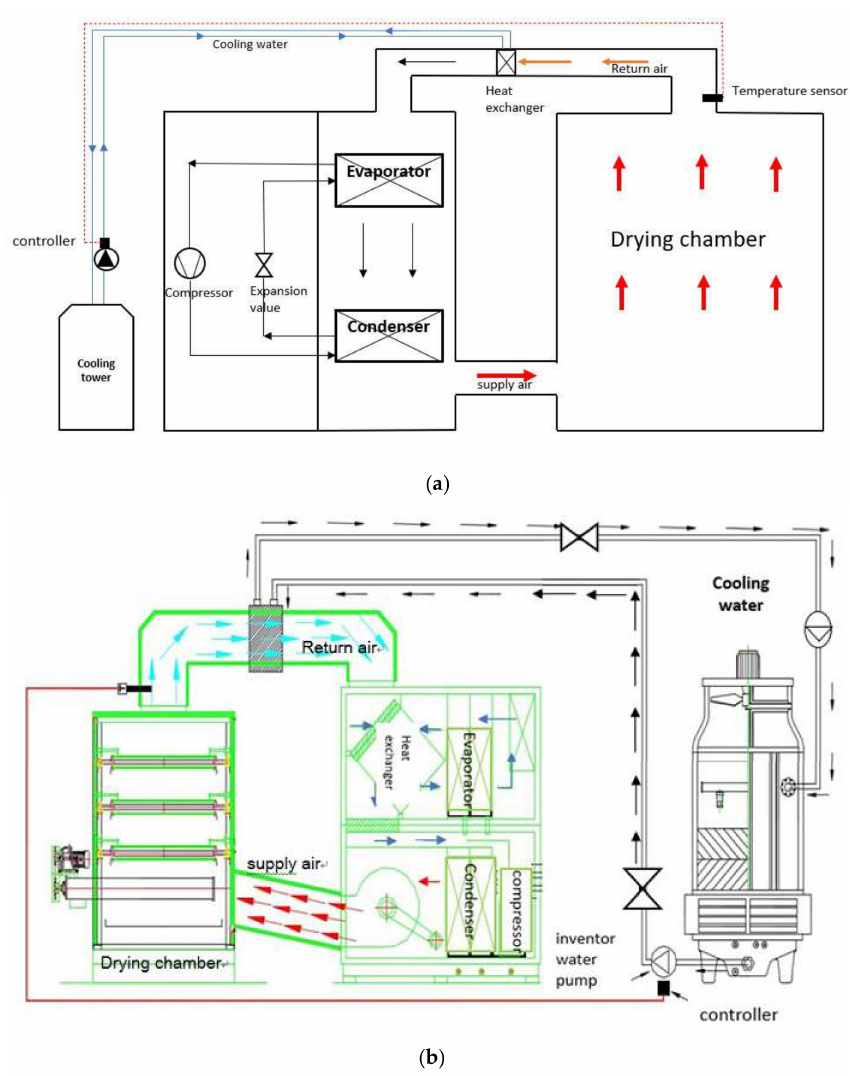
Figure 6. Schematic diagram of the heat pump drying system with auxiliary cooling subsystem. ( a ) Design of auxiliary cooling subsystem. ( b ) Side view of the drying system with auxiliary cooling subsystem and heat recovery